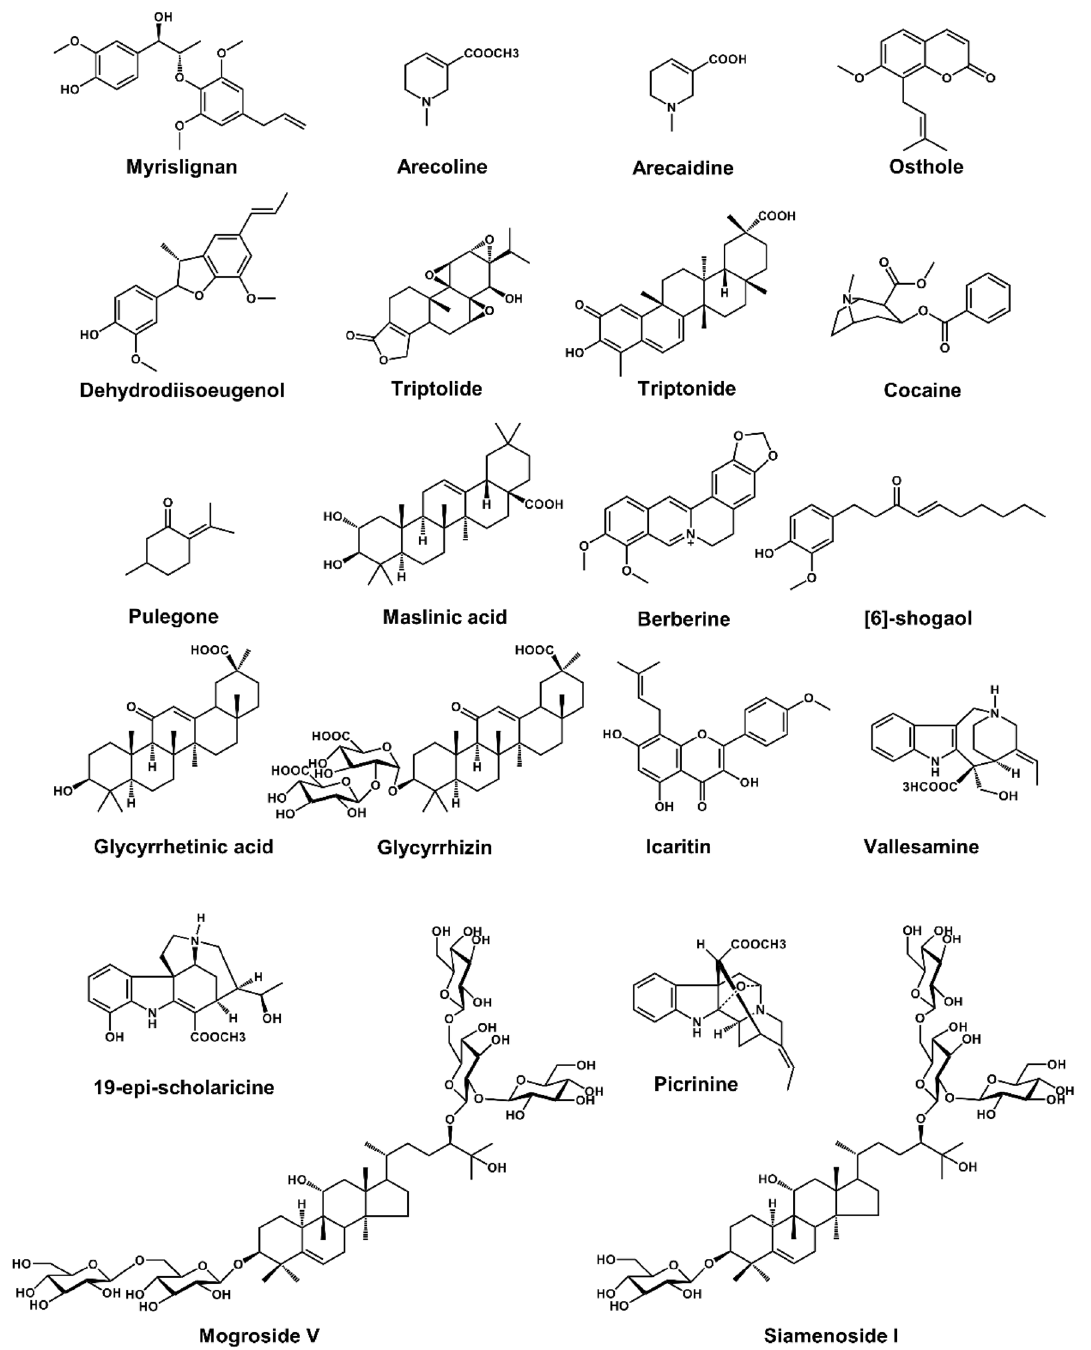
Fig. 2 Chemical structure of some natural products. The natural products’ metabolic map has been evaluated by using